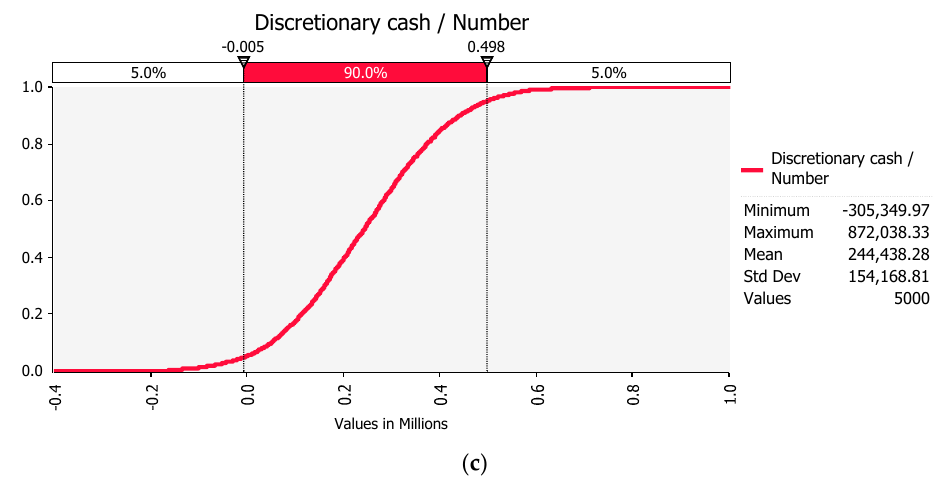
Figure 5. “@Risk” simulated risk profile for the dairy farm, showing distribution of discretionary cash ( a ); tornado chart ( b ); and cumulative distribution of discretionary cash ( c ).